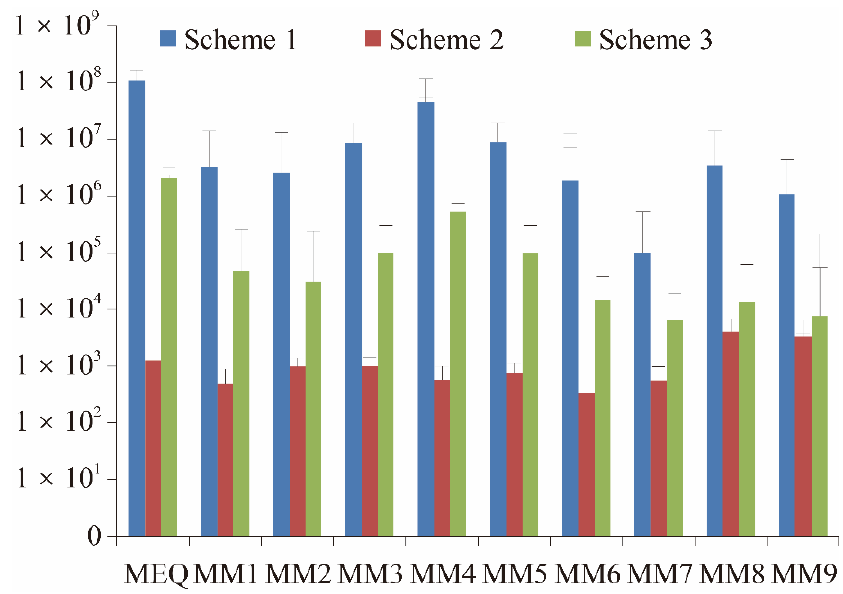
Figure 1. Optimization of extraction efficiency with three different schemes (n = 6).